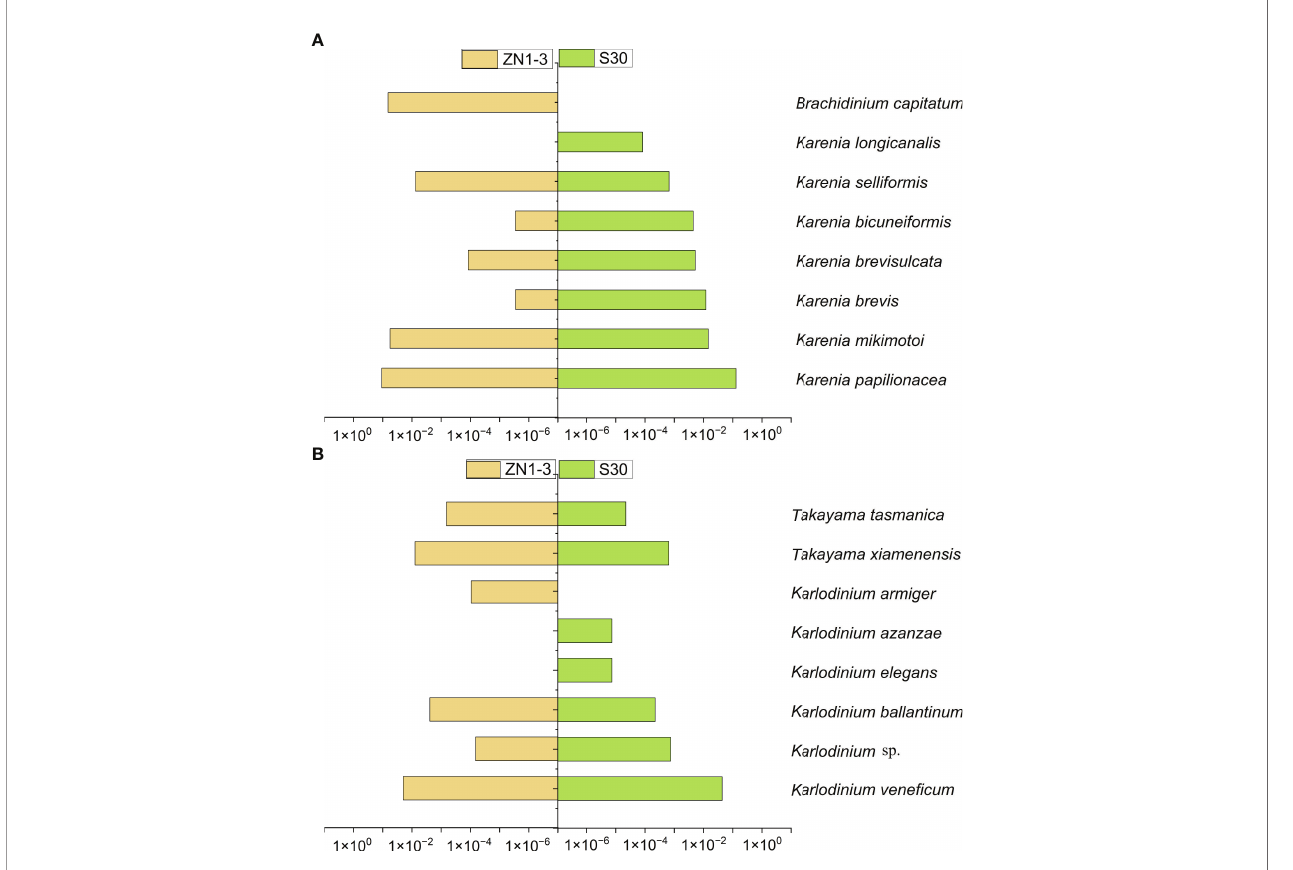
FIGURE 6 | Comparison of the statistics OTUs annotation results between sample ZN1-3 and S30. (A) : the tags proportion of the annotated as Karenia species in the two SCS samples. (B) : the tags proportion of the annotated as Karlodinium and Takayama species in the two SCS samples. (Column length represents the tags proportion of the annotated Kareniaceae species with more than 98% identity in the total assembled Kareniaceae tags).